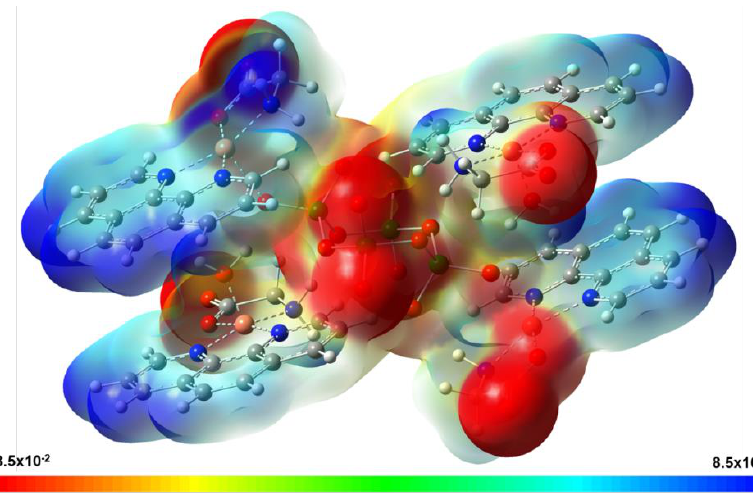
Table 4. Relative electronic energies (  E) and interaction energies (E int ) (in kcal mol −1 ) for singlet, triplet, and pentet lowest electronic states of Compound 1.